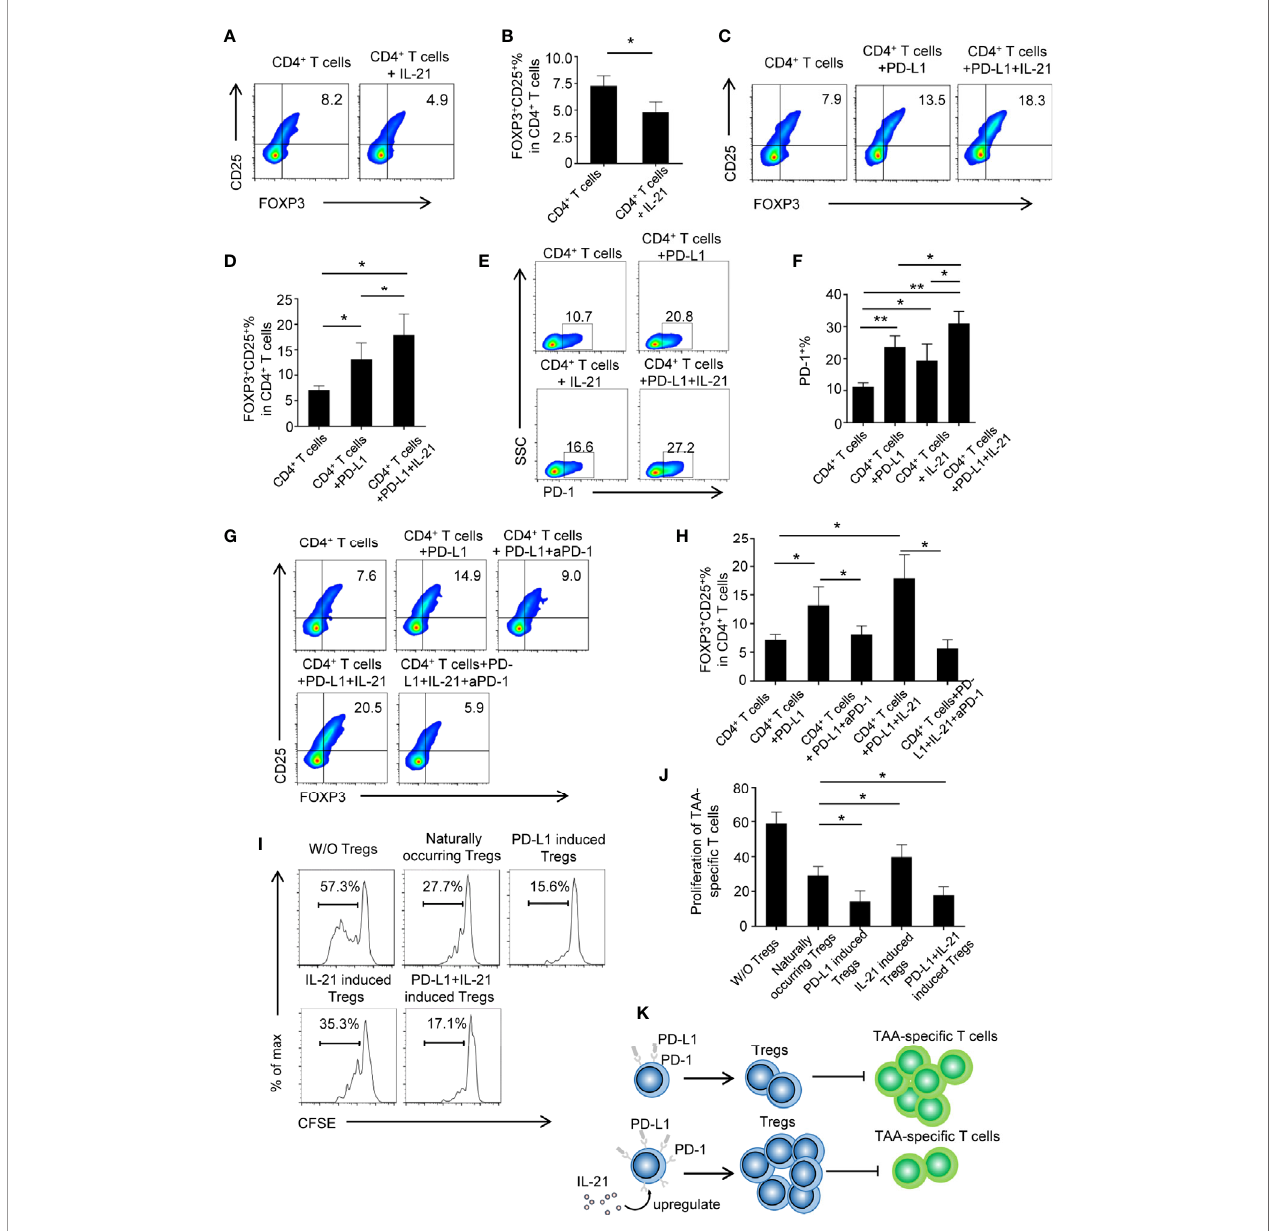
FIGURE 4 | IL-21 contribute to PD-L1 induced Tregs generation in PD-1 dependent manner. (A, B) CD4 + T cells from human peripheral blood were stimulated with anti CD3/28 antibody coated beads with or without IL-21. The percentage of FOXP3 + CD25 + Tregs were quantitated and shown. (n = 5, *P < 0.05, by Student ’ s t- tests.) (C, D) CD4+ T cells were treated with or without PD-L1 or/and IL-21. Percentage of FOXP3 + CD25 + Tregs was shown (n = 5, *P < 0.05, by Student ’ s t-tests). (E, F) Proportion of PD-1 expressing CD4 + T cells in the presence or absence of IL-21 or PD-L1 (n = 4, *P < 0.05, **P < 0.01 by one way ANOVA). (G, H) CD4+ T cells were treated with or without PD-L1 or/and IL-21 in the presence or absence of PD-1 neutralization antibody. Percentage of FOXP3 + CD25 + Tregs was shown (n = 5, *P < 0.05, by Student ’ s t-tests) (I, J) Induced Tregs were cocultured with CFSE labeled TAA-T responder cells at ratios of 1:2 and in the presence of anti- CD3/anti-CD28 antibodies. Proliferation of responder cells were assessed after 72h by fl ow cytometry. Plots are representative of fi ve separate experiments, *P < 0.05, compared with naturally occurring control Tregs by Student ’ s t-tests. (K) Schematic fi gure illustrating that IL-21 promoted PD-L1-induced Treg generation in a PD-1-dependent manner, IL-21 and PD-L1-induced Tregs inhibited TAA-speci fi c T cell proliferation at a greater degree than naturally occurring